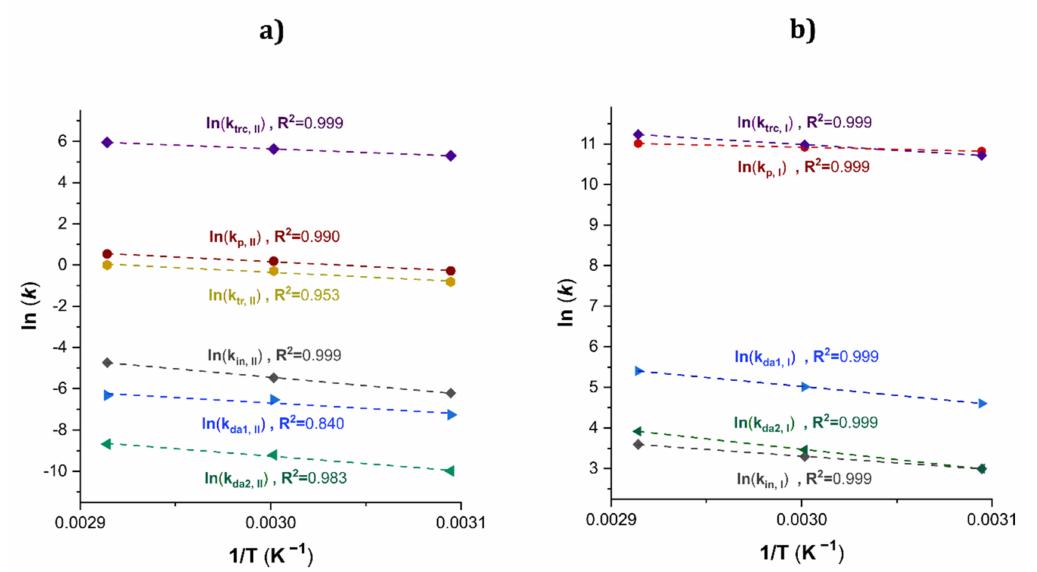
Figure 9. Arrhenius plot for a set of k j values for the β -myrcene CCTP for Exps. 1, 2 and 3. ( a ) Type II. ( b ) Type